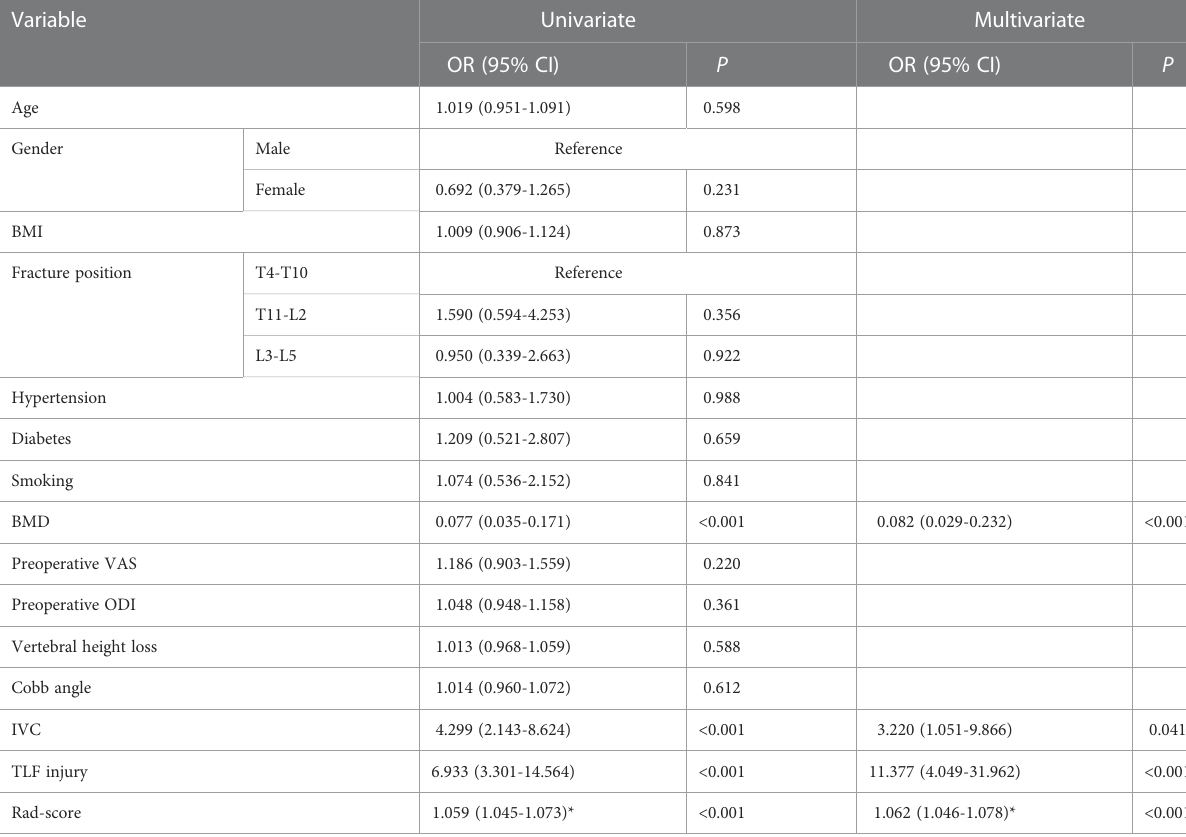
TABLE 1 Univariate and multivariate Logistic regression analyses for independent correlates of